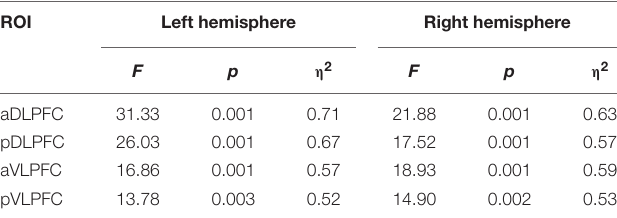
TABLE 4 | Task effects in the left and right hemisphere ROIs for OAs ( (cid:49) HbR). ROI Left hemisphere Right